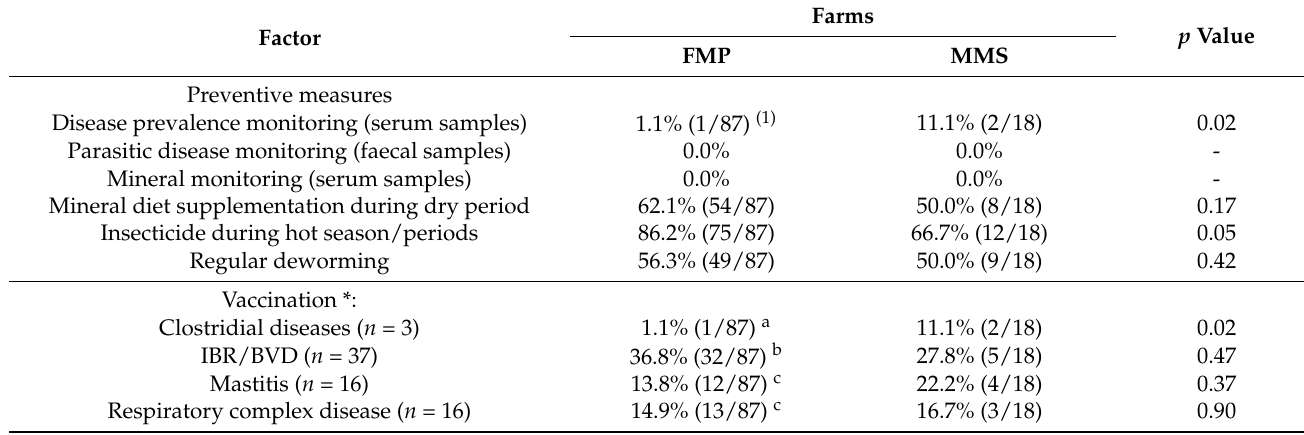
Table 4. Preventive health measures were adopted by fixed (FMP) and mobile (MMS) milking system